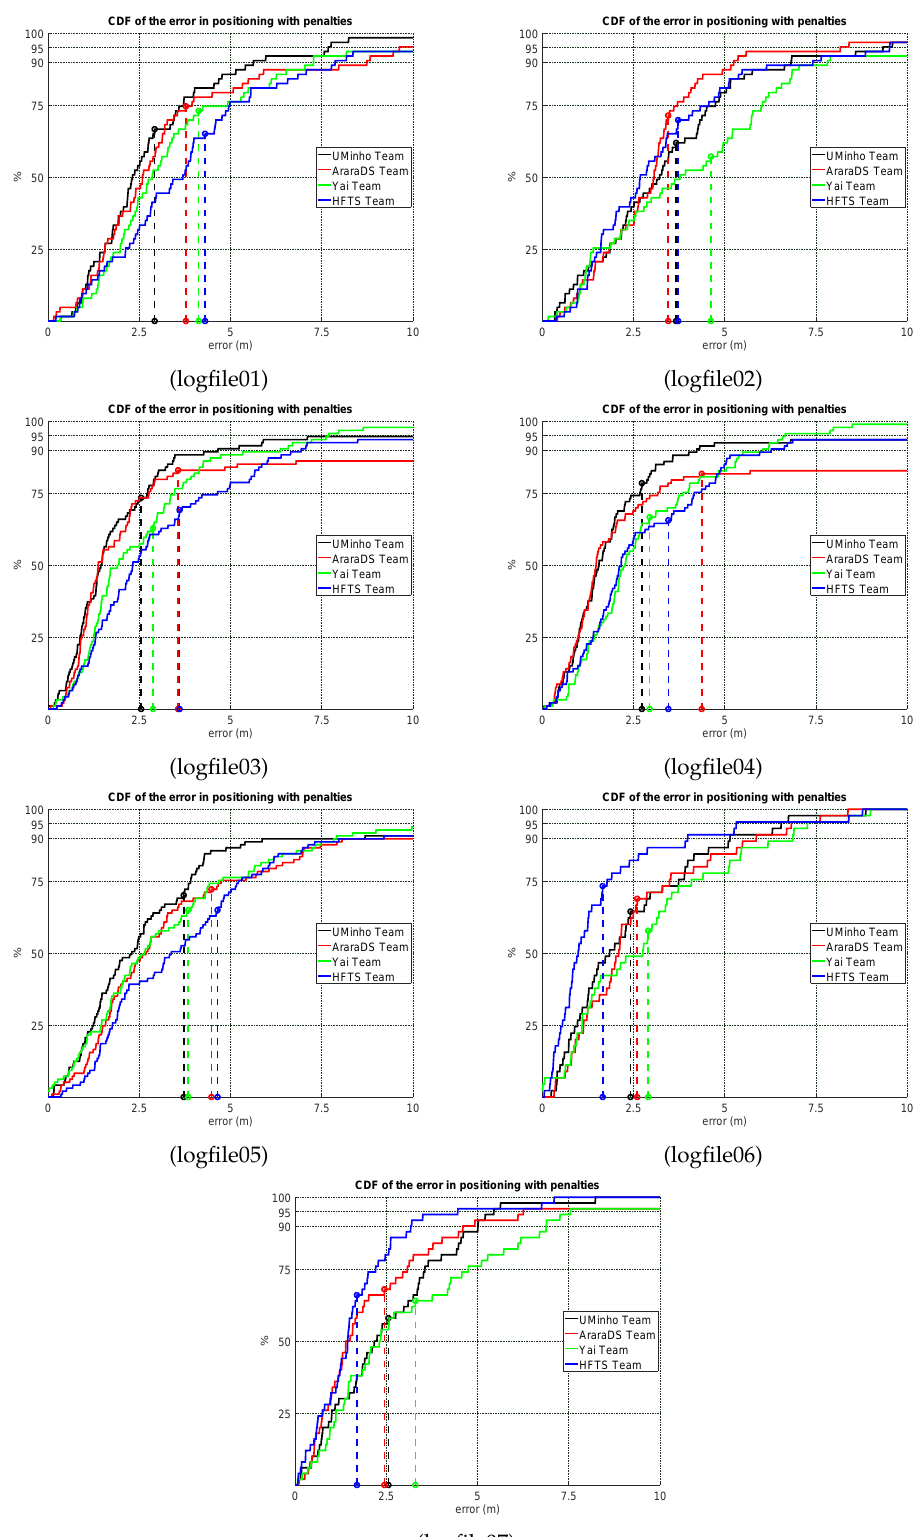
Figure 3. Competition Results—Cumulative Distribution Function of the positioning error plus the mean positioning error (vertical dashed lines) in each